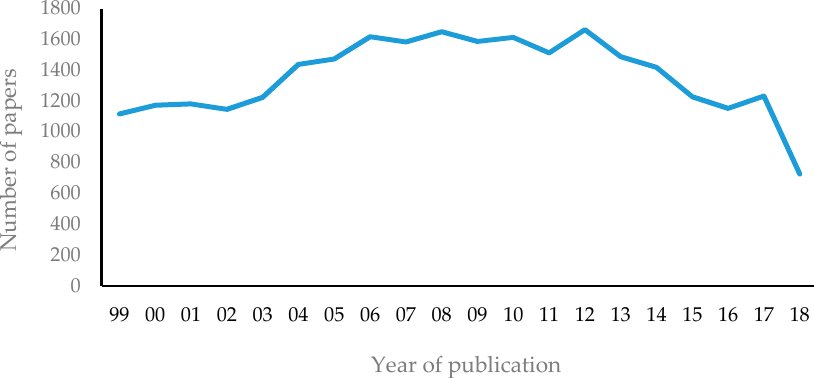
Figure 2. Number of biochemical papers published by year.